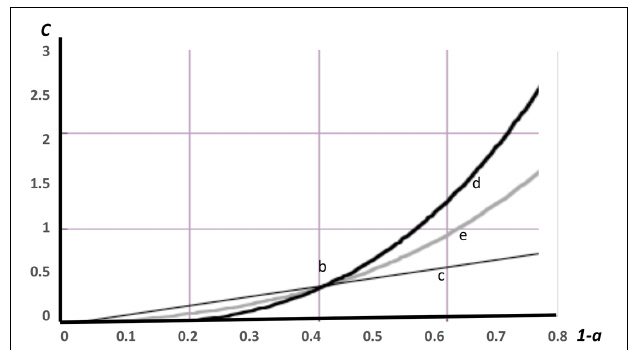
FIGURE 3 | Cost functions for prevention and restoration: C n = 1 − a -linear cost function-normal black line, C c = 6 . 06 ( 1 − a ) 3 - convex cost function-heavy black line, E ( C ) = 0 . 5 C n + 0 . 5 C c -expected cost-heavy gray line, b = ( 0 . 406 , 0 . 406 ) , c = ( 0 . 559 , 0 . 559 ) , d = ( 0 . 620 , 1 . 466 ) , e = ( 0 . 613 , 1 . 003 ) . Note that the 1 − a coordinates for c , d , and e are certainty